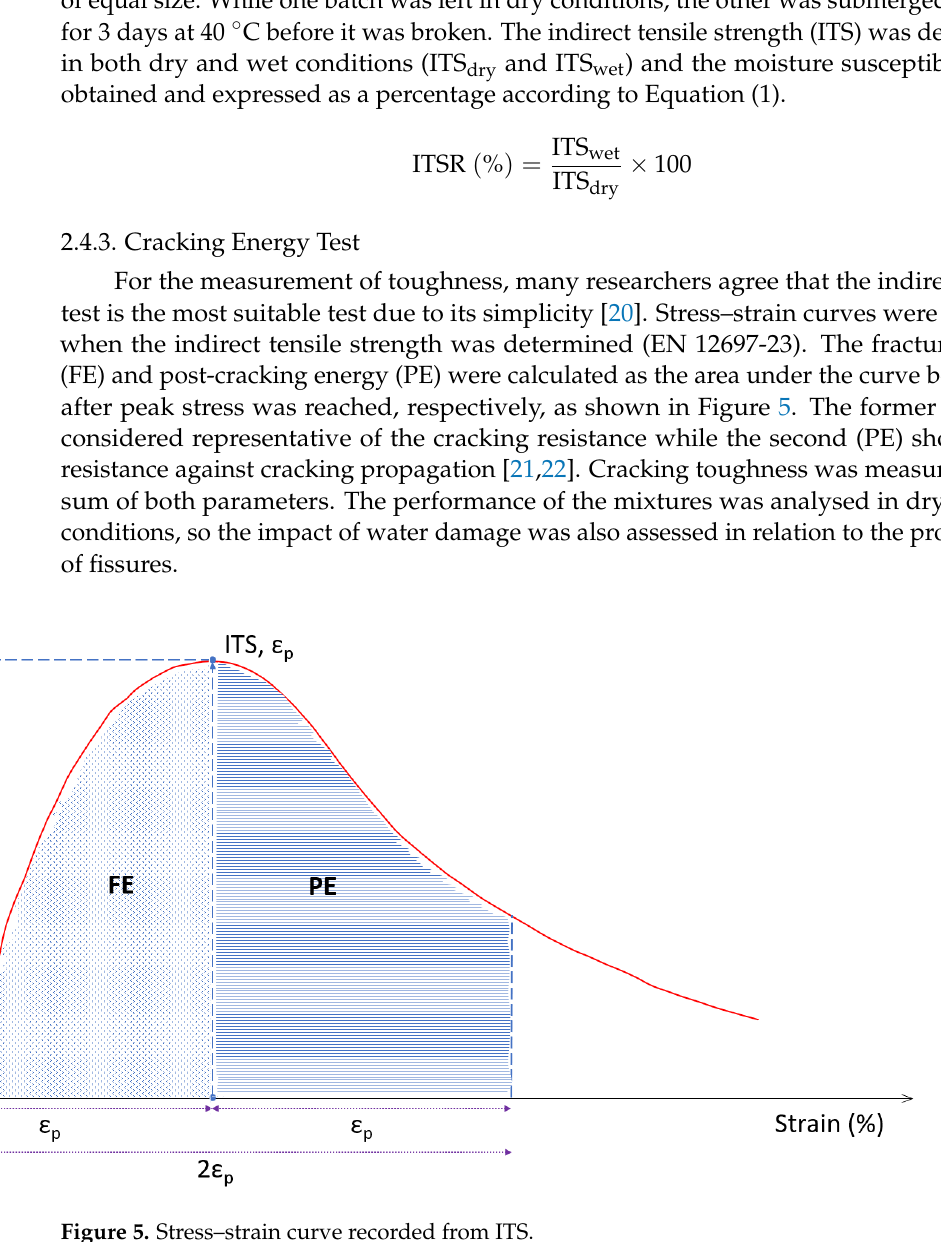
Figure 5. Stress–strain curve recorded from